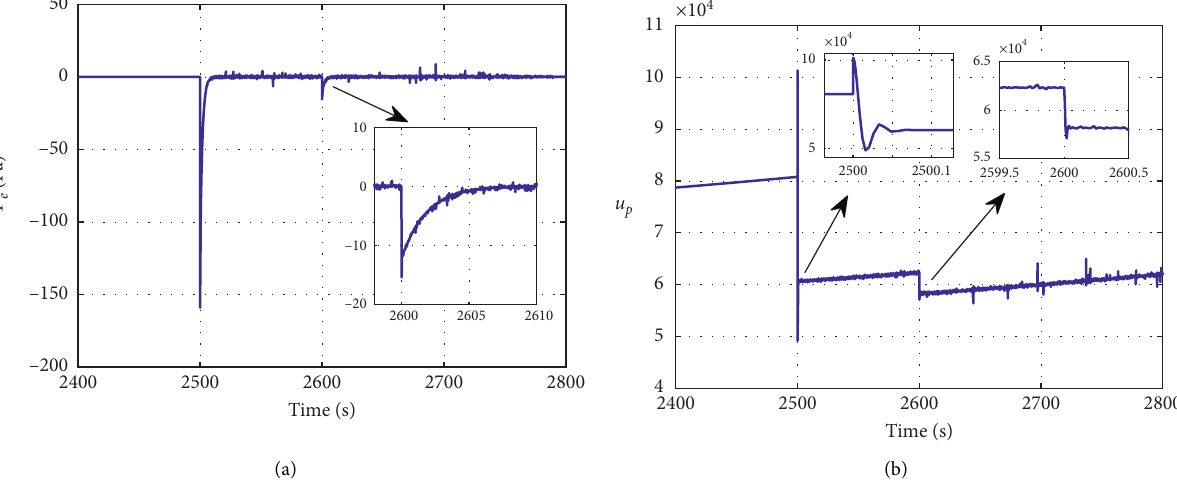
Figure 13: Pressure error and control input of sequential double faults after reconfiguration.